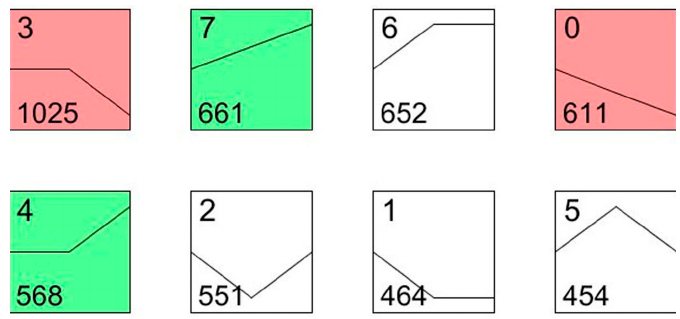
Figure 4. STEM (Short Time-series Expression Miner) clusters of expression profiles. The profiles are ordered based on the p -value significance of the number (at bottom-left corner) of genes assigned versus expected. The colored square frame denotes significant profiles ( p -value ≤ 0.01). Each graph displays the mean pattern of expression (black lines) of the profile genes. The number of profiles in each cluster is at the top left corner of each STEM and the number of genes in the bottom left corner of the panels. The x -axis represents stages, and the y -axis represents log2-fold change in gene expression.